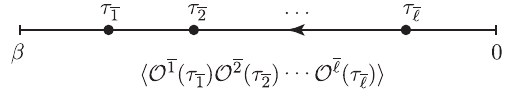
FIG. 2. MF time ordering is similar to ZF ordering (Fig. 1), except that the times τ ¯ are constrained to the interval ð 0 ; β Þ i